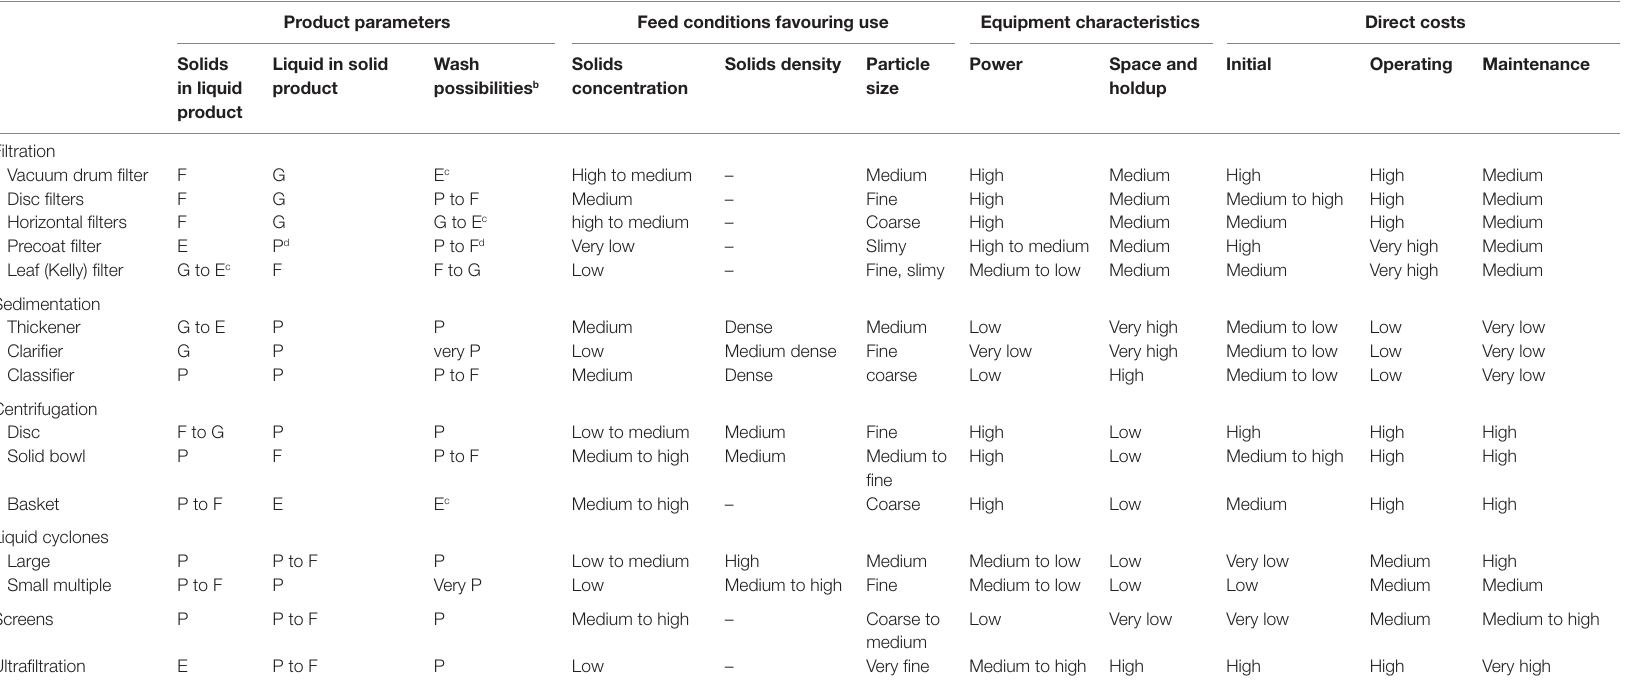
TaBle 4 | comparative performance of solid–liquid separation equipment a (couper et al.,